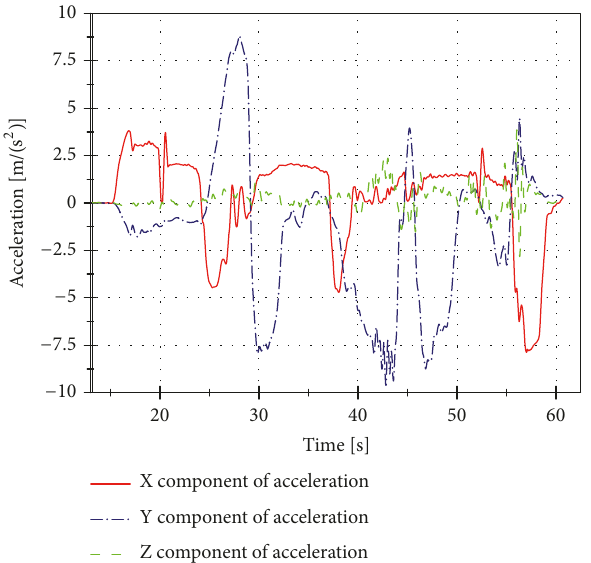
Figure 23: Set of data obtained from acquisition system, vehicle acceleration